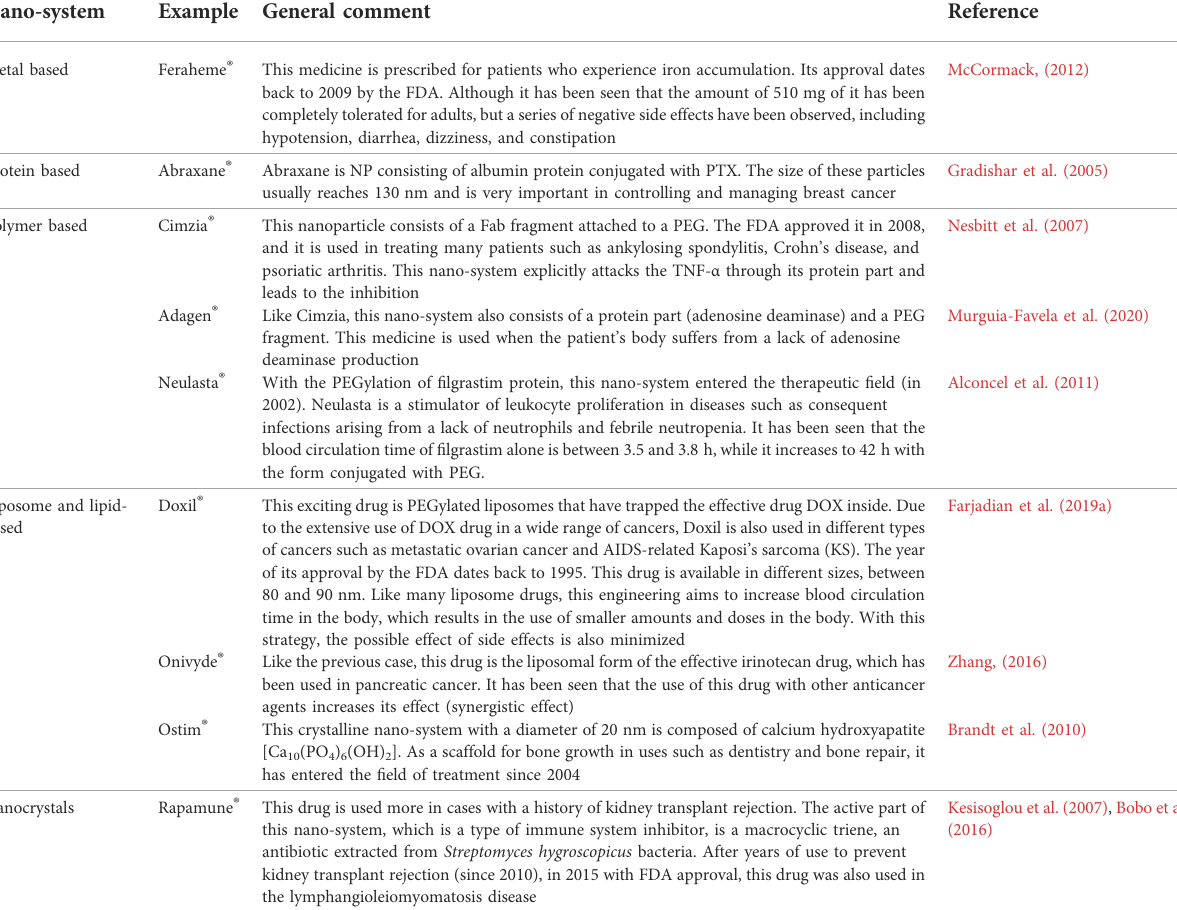
TABLE 5 List of approved nano-systems in market and therapeutic